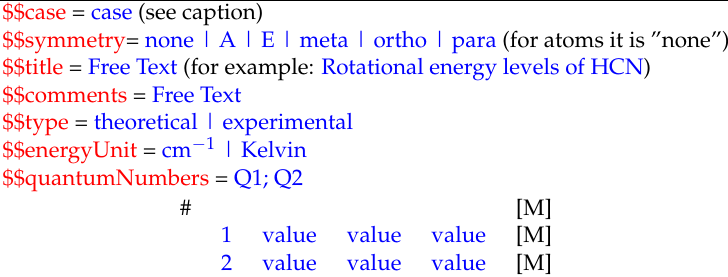
Table A2 provides a template of an “Energy table” input; it includes the metadata of Table 2. Table A2. Template of an energy table input as requested by the import script. The metadata are in red and the values in blue. The “case” metadata are dcs | hunda | hundb | ltcs | nltcs | stcs | lpcs numbers. Both the case and the quantum numbers are described in the case-by-case document (http://www.vamdc.eu/documents/cbc-1.0/). In the second part of the table, all fields are mandatory. The first column gives the label attached to the energy level; this label identifies the levels in the rate coefficient table. The number of levels must be the number of levels necessary to identify the energy levels of the rate coefficients table. The second column gives the energy (in cm − 1 ), the two following columns give the values of quantum numbers identified in the parameter $$quantumNumbers. In the current template, there are two quantum numbers and two levels.